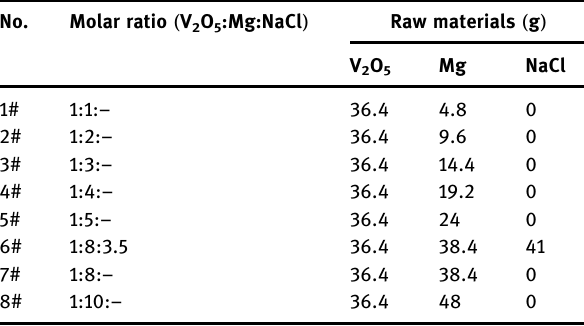
Table 1: The ratio of raw